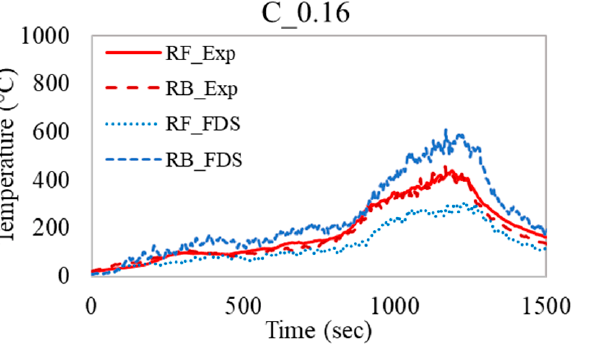
Figure 19. Gas layer temperature for slot cases.